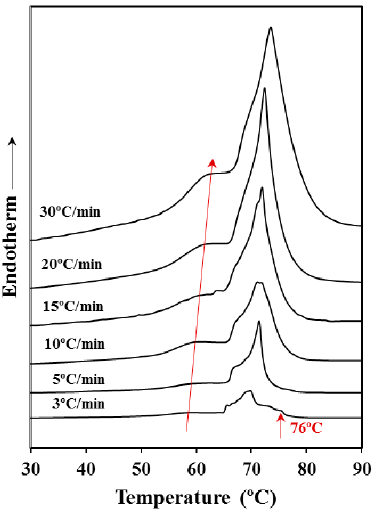
Figure 2. Calorimetric (DSC) heating runs performed at the indicated rates with the commercial P4HB (Poly(4-hydroxybutyrate))